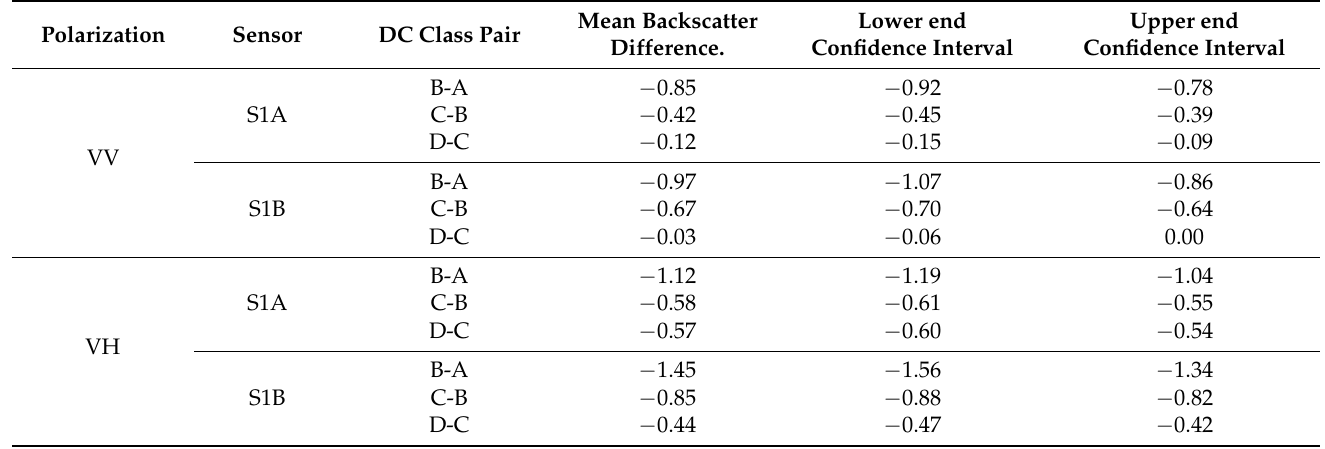
Table 2. Pairwise differences between DC classes: A = 0 to 1, B = 1 to 10, C = 10 to 100, D = 100 to 1000. Adjusted p -Value <<